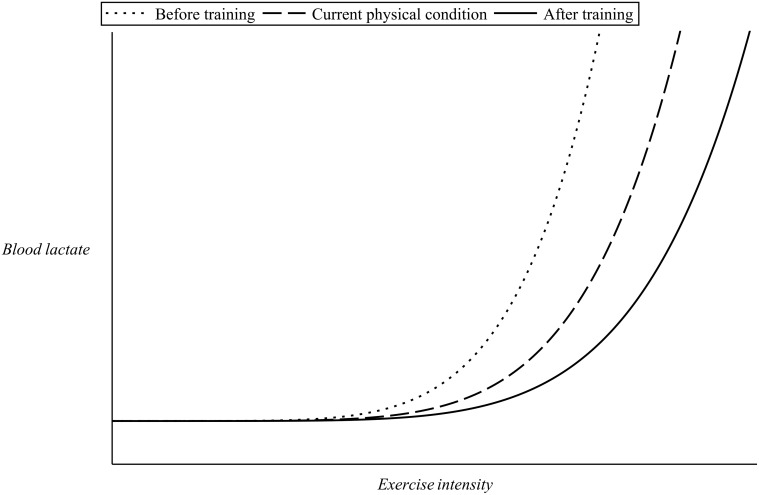
Effect of training on blood lactate.